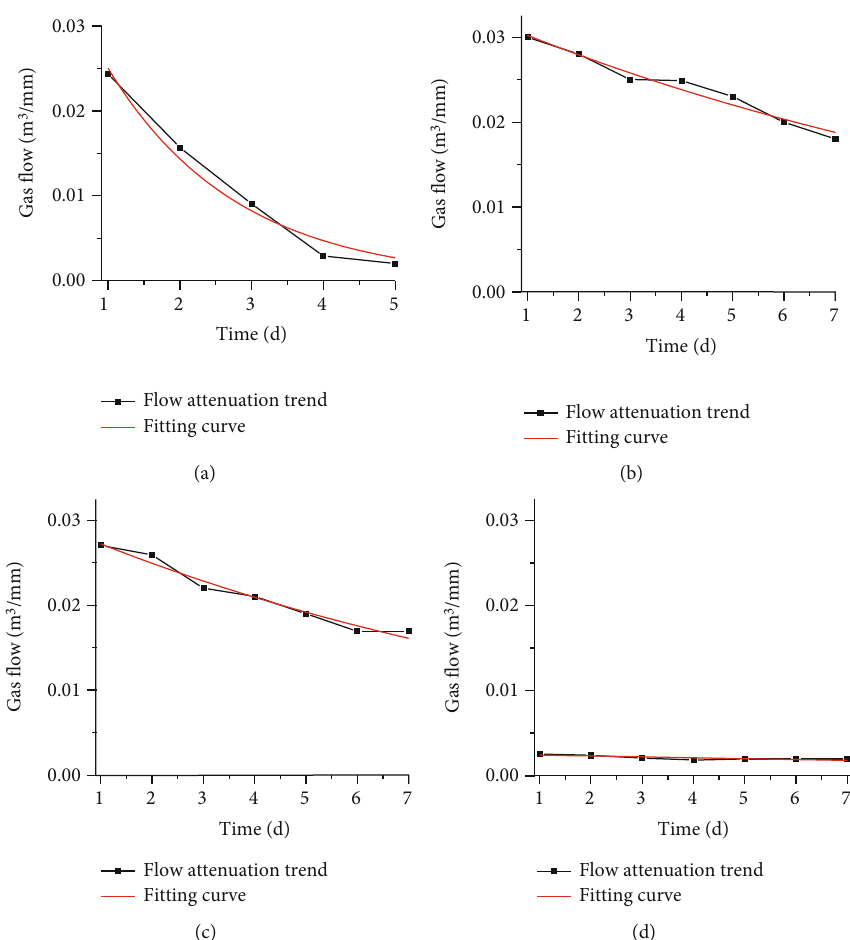
Figure 16: Natural methane fl ow curve with time for some boreholes before and after blasting. (a) Average natural gas fl ow data curve of each borehole before blasting; (b) data curve of blasting holes after blasting; (c) data curve of 1# monitoring hole after blasting; (d) data curve of 6# monitoring hole after